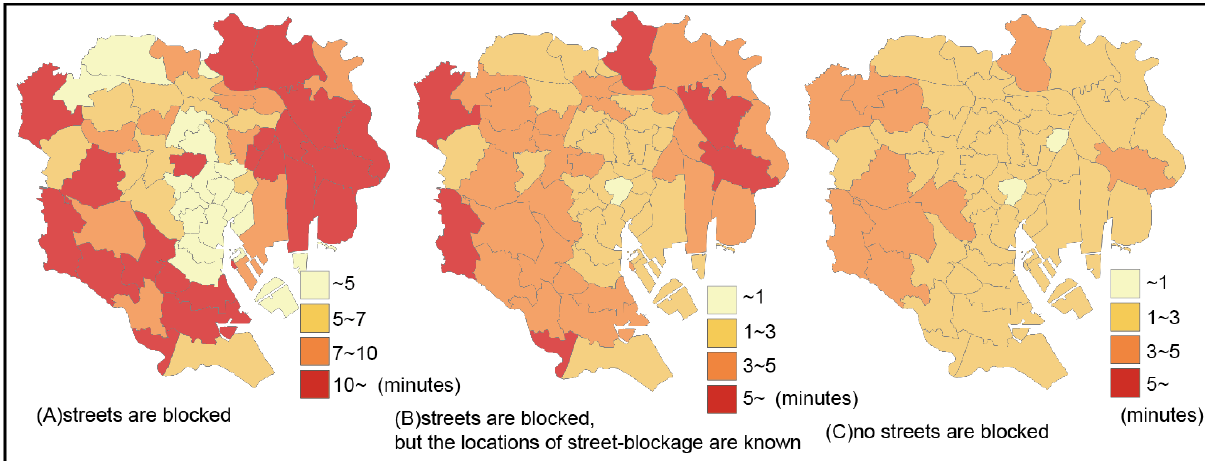
Figure 8. Spatial distribution of access time of firefighters in case A to Table 9. Summary of sumida-ward and shinagawa-ward